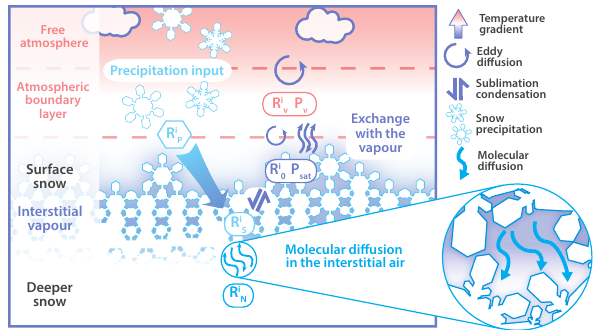
Figure 1. Schematic of the different contributions to snow isotopic composition ( R i stands for the composition of isotope i in phase X : X P is precipitation, V is vapour, S is surface snow, N is the deeper snow, 0 is vapour at equilibrium with the snow and P v and P sat are the water vapour partial pressure and the saturated vapour pres- sure, respectively). Above the surface, both the precipitation and the sublimation–condensation cycles can contribute to the surface com- Figure 2. Map of Antarctica showing the East Antarctic Plateau position; in the open-porous firn below the surface, ice crystals can (grey line is the contour of 2500ma.s.l.) indicating the location exchange with the air through the pores and may be influenced by of the sampling sites (solid squares). Colours indicate the annual wind pumping. Deeper in the firn, molecular diffusion in the inter- mean surface air temperature at 2m modified from the ERA-Interim stitial air affects the snow isotopic composition. dataset from 1979 to 2009 (Nicolas and Bromwich,